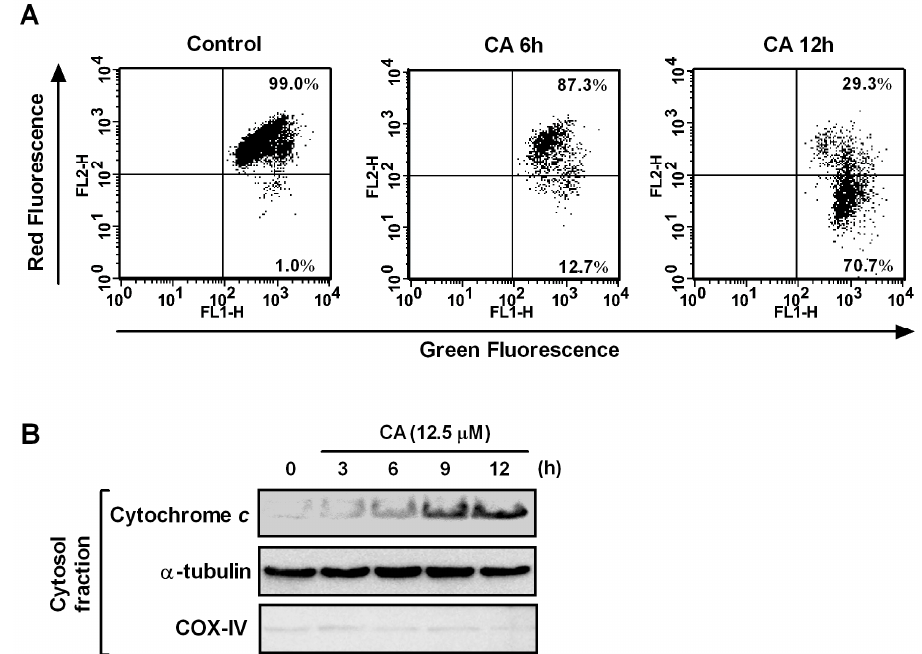
Figure 6. Effect of CA on mitochondrial dysfunction and Bcl-2 family proteins. ( A ) Effect of CA on the loss of ∆ψ . HL-60 cells were treated with 12.5 μ M CA for the times m indicated and analyzed by flow cytometry after staining with JC-1; ( B ) Cytochrome c release into the cytosol after treatment with CA. HL-60 cells were treated with 12.5 μ M CA for the times indicated, and the cytosolic fraction was analyzed to detect cytochrome c by Western blotting. α -Tubulin and COX-IV were used as cytosolic and mitochondrial fraction controls, respectively. The data shown are representative of three independent experiments with similar